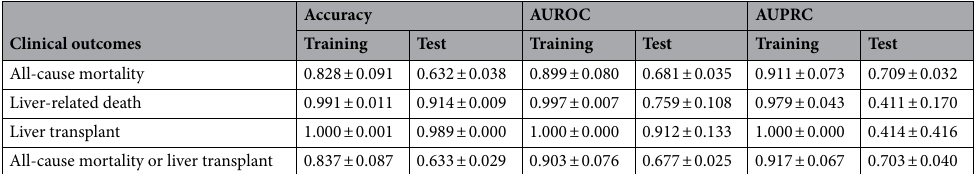
Table 4. Mean (± standard deviation) model performance measures for stacking ensemble learning in Training Set and Test Set across the nested five-fold cross-validation with 100 repetitions in patients with AATD-LD (N = 455), respectively. AUROC = area under the receiver operating characteristic, AUPRC = area under the precision-recall curve.